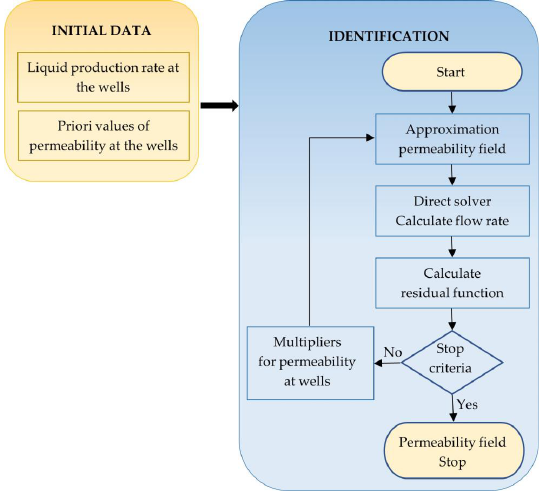
Figure 1. General scheme of the solution method.